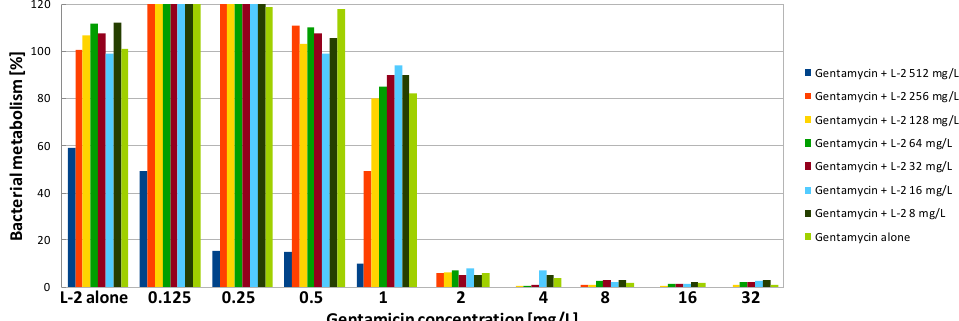
Figure 4. Activity of gentamicin in combination with lipopeptide 1 (L-1) against PA biofilm. Results presented as percentage of metabolic activity in comparison to positive (100%) and negative (0%) controls; RSD ≤ 20%.